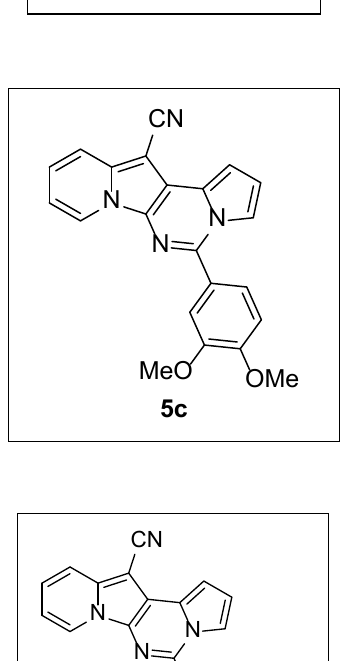
5-(3,5-Dimethoxyphenyl)pyrrolo[1 (cid:48) ,2 (cid:48) :1,6]pyrimido[5,4- b ]indolizine-12- carbonitrile (5d). Green solid, m.p.: 238.8–239.5 ◦ C (36.1 mg, 89%); 1 H